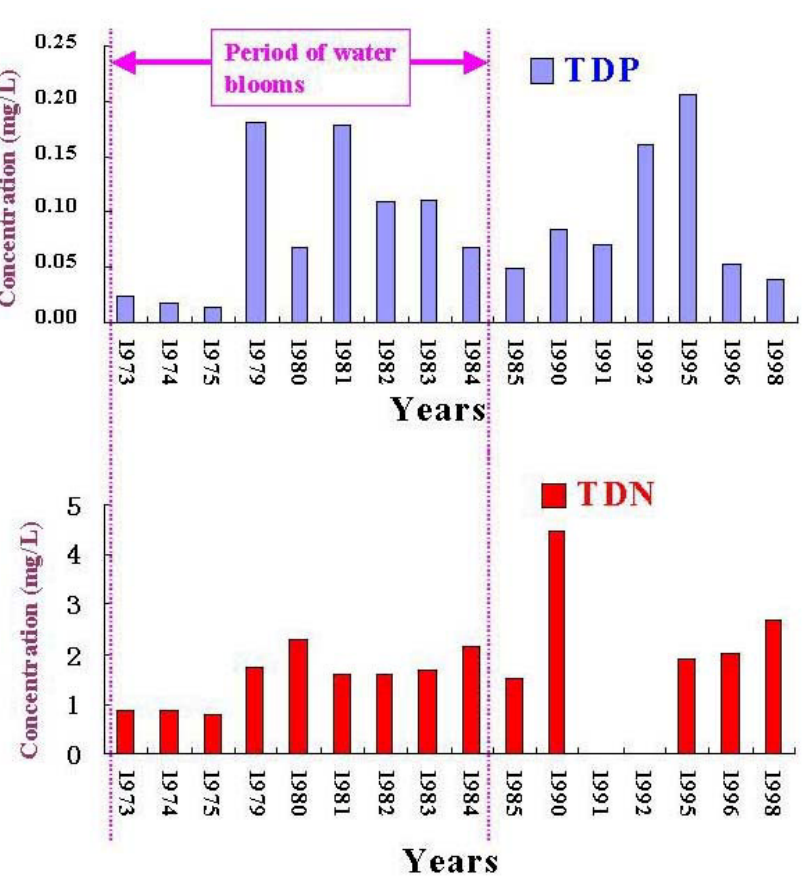
FIGURE 5. Annual mean concentrations of total dissolved nitrogen (TDN) and total dissolved phosphorus (TDP) at mid-lake Station II of Lake Donghu during 1973–1998 (adapted from Tang and